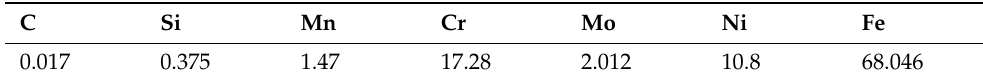
Table 1. Chemical composition of 316L steel (in